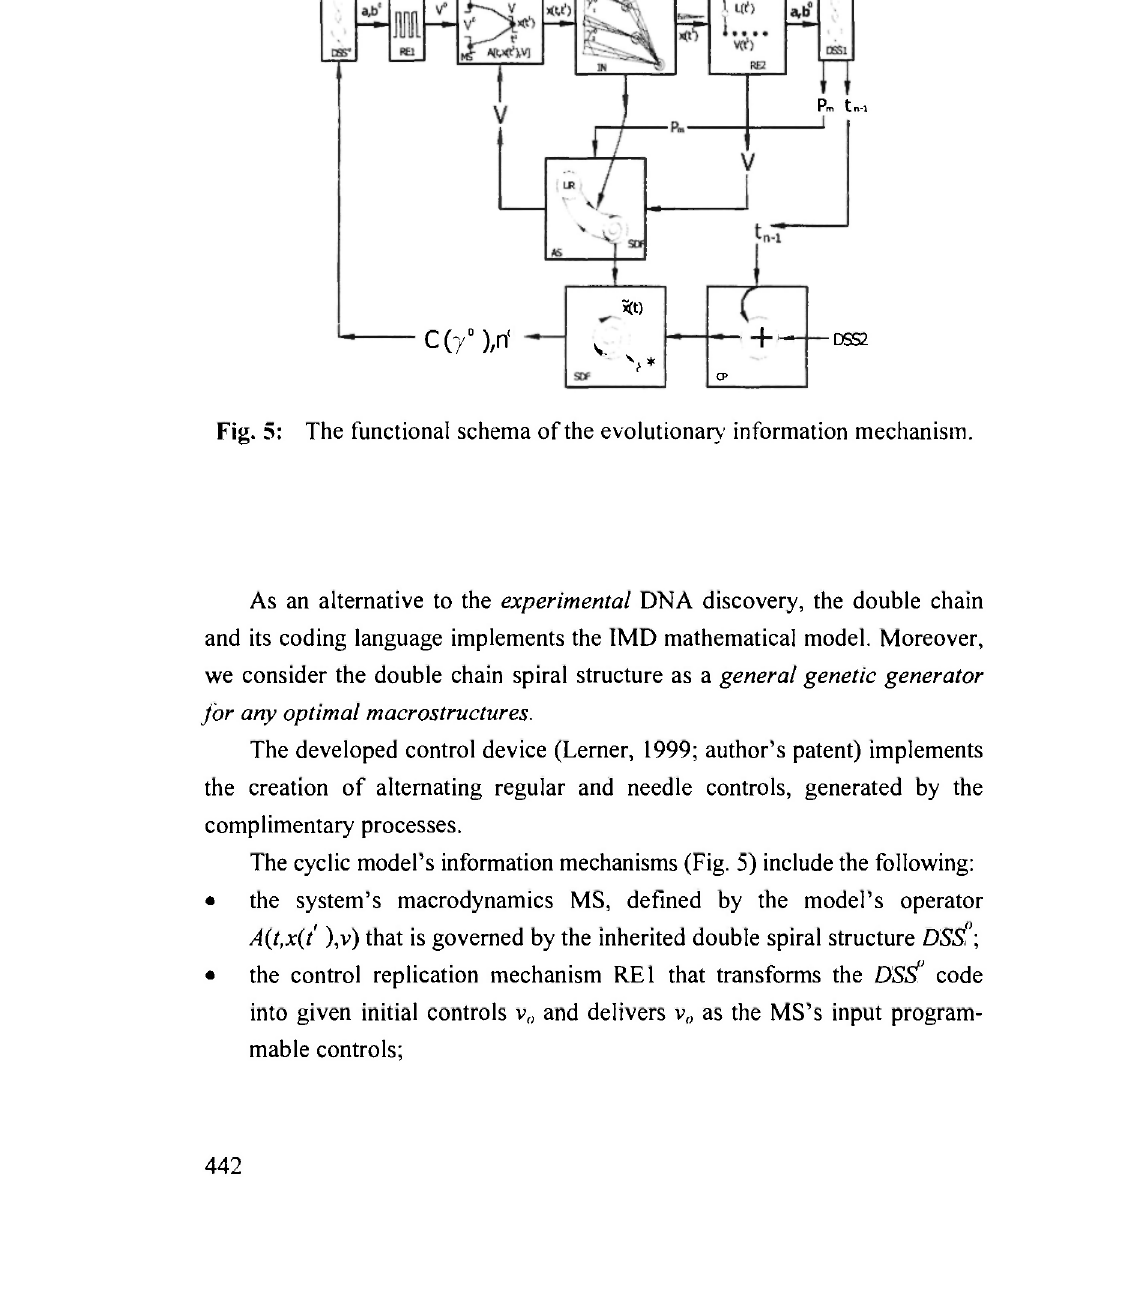
Fig. 5: The functional schema of the evolutionary information mechanism.